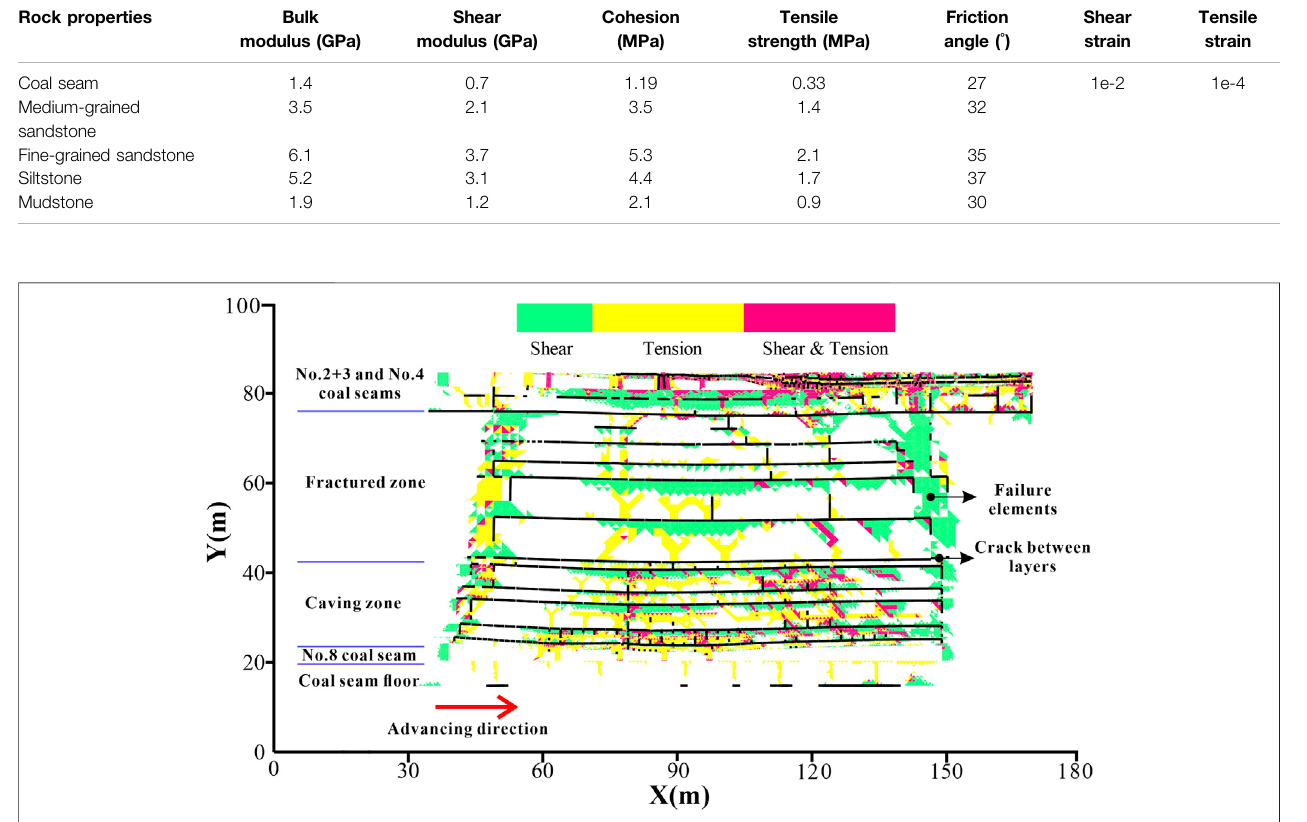
FIGURE 8 | Distribution of failed zones in the roof of No.18401